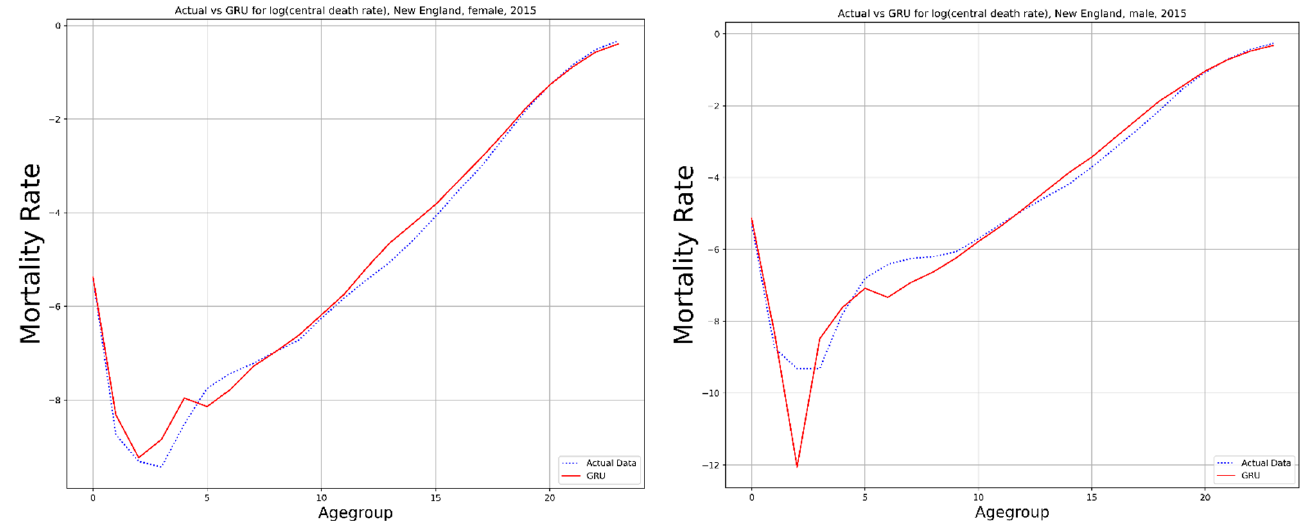
Figure 13. The predictions of the log-mortality rate for New England female ( left ) and male ( right ), 2015: GRU (red) vs. real (blue).